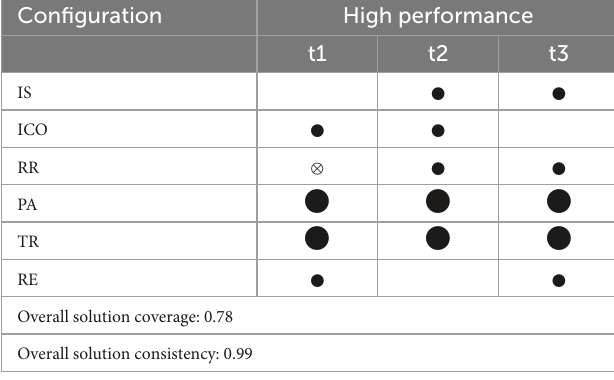
TABLE 4 Configurations of human resource management (HRM) practices for high-performing enterprises.